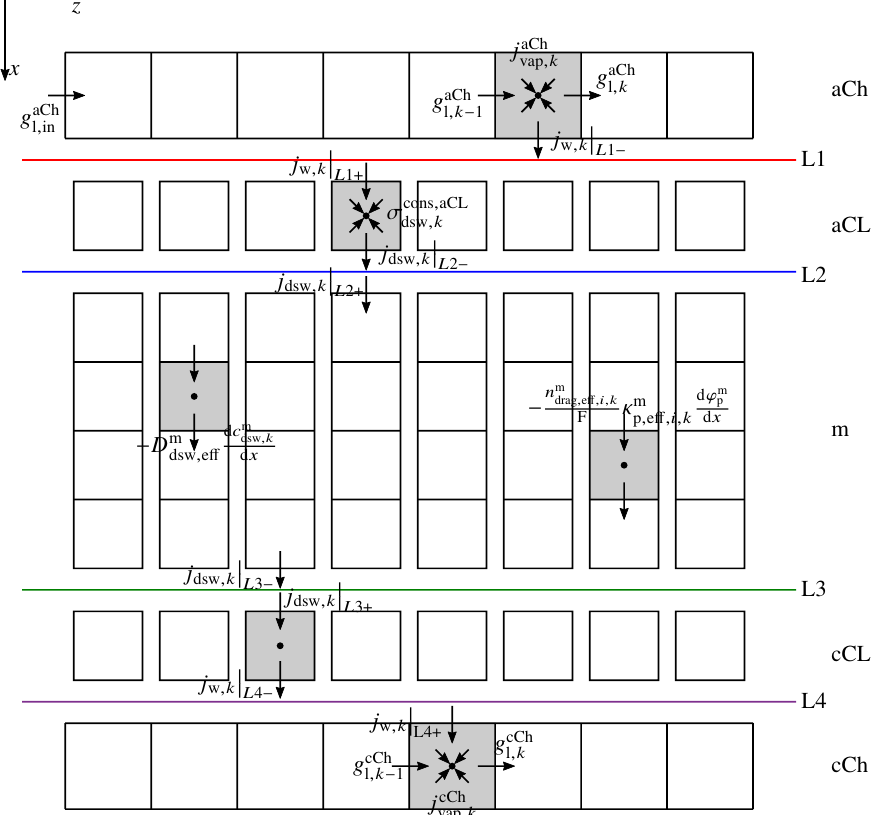
Figure 2. Schematic discretization pattern (exemplary for liquid and dissolved water): sandwich direction divided into the anode channel (aCh), anode catalyst layer (aCL), membrane (m), cath- ode catalyst layer (cCL) and the cathode channel (cCh). Boundaries between the layers L1, L2, L3 and L4. Channel water flux densities in the z -direction are represented as g aCh/cCh densities as j dsw, k for dissolved water and j w, k for liquid water. σ cons,aCL